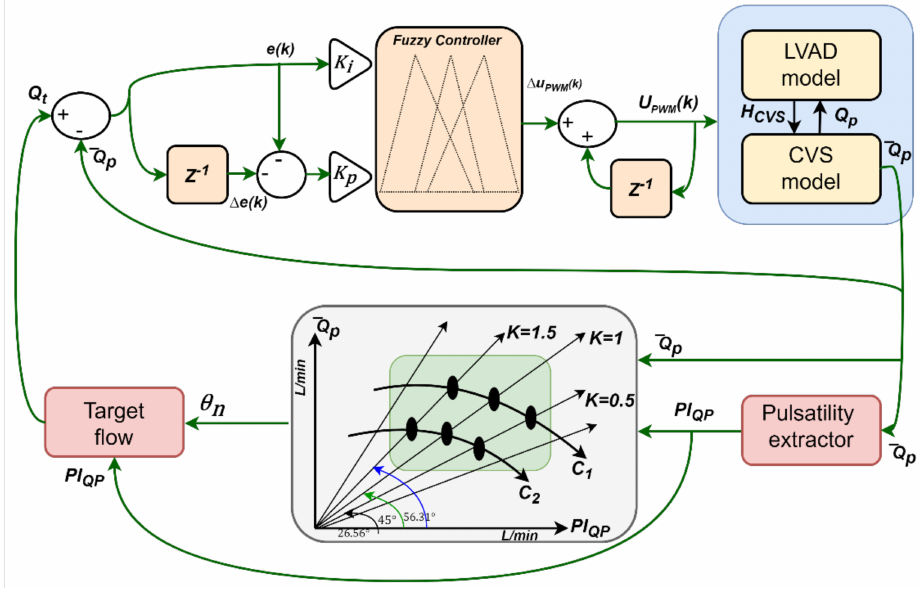
Figure 1. Block diagram of the control